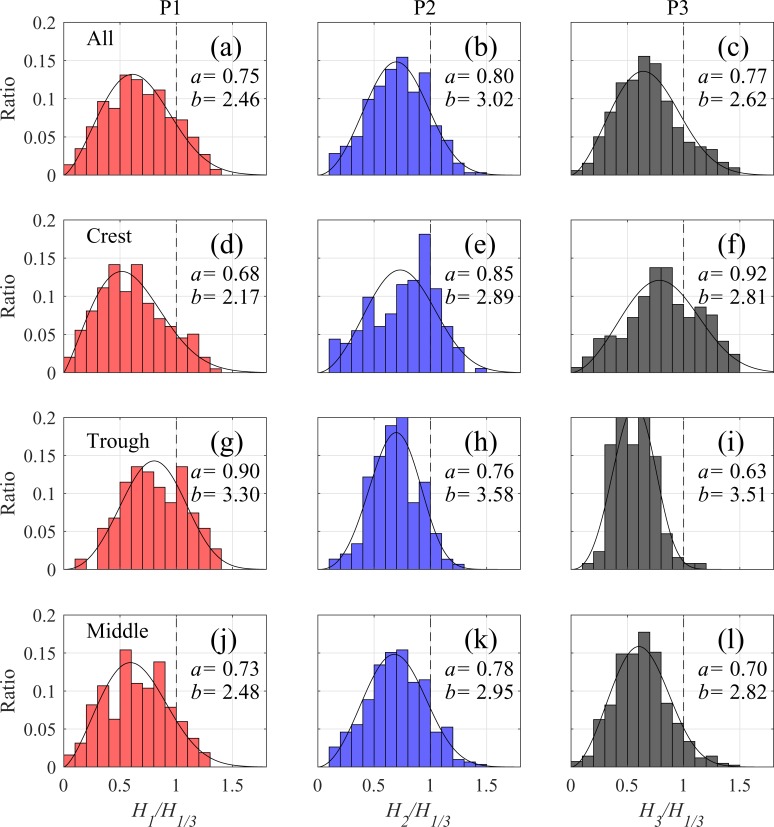
(a)–(c) Normalized wave histograms of total waves during peak typhoon period T2, on the (d)–(f) waves crests, (g)–(i) troughs, and (j)–(l) middles of ranges at observation points P1, P2, and P3. The vertical axis indicates the ratio of the number of the individual waves in each bin to the number of total waves of each group. Solid curves indicate Weibull distributions fitted to each histogram, with values of scale and shape parameters (a and b) are shown in each graph.